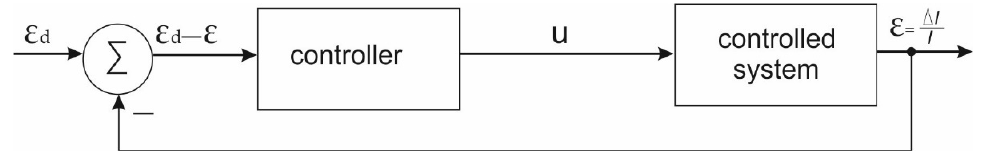
Figure 18. Flowchart of the controller design algorithm.